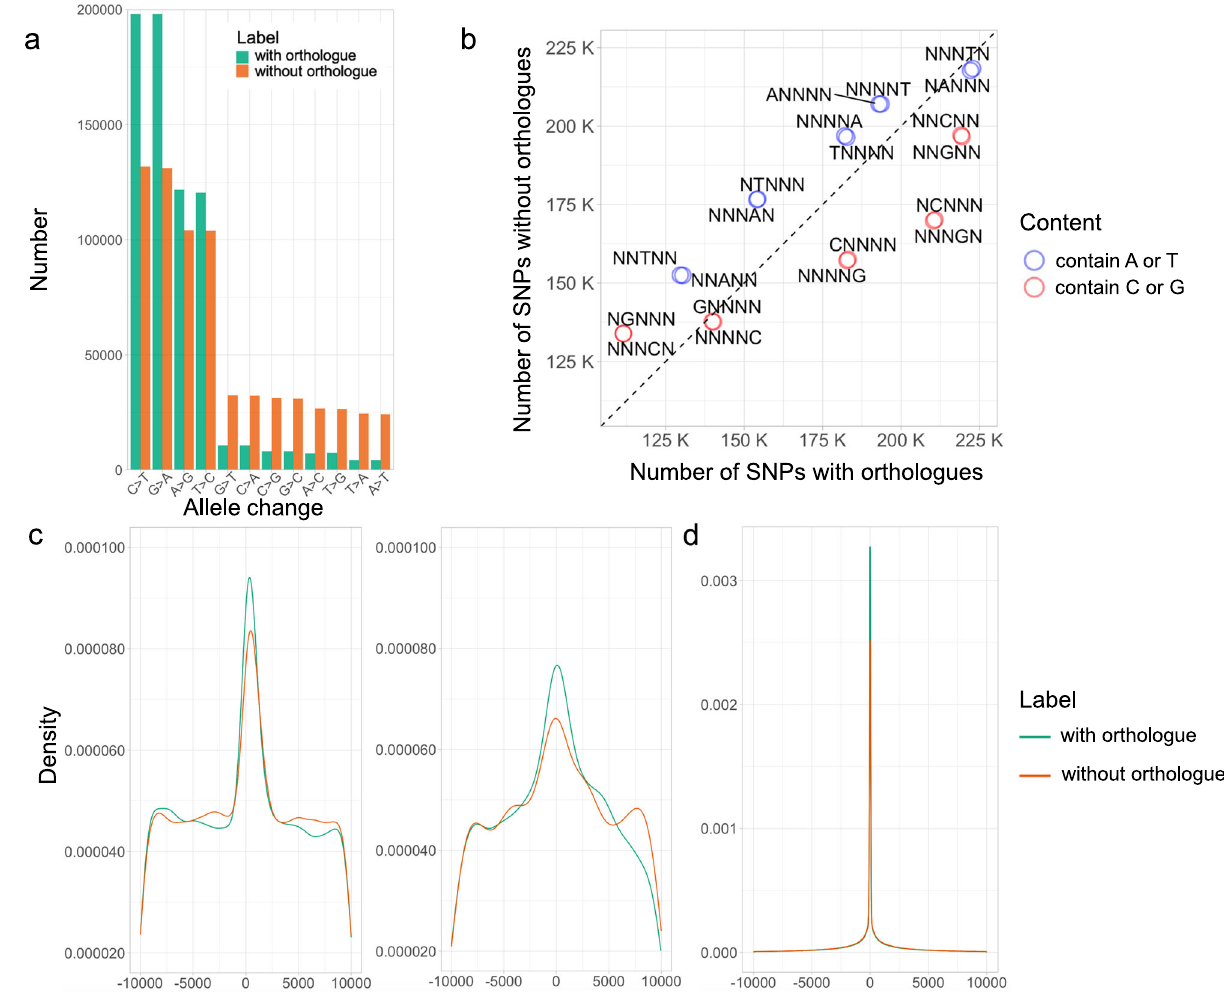
Fig. 2 The characteristics of human variants with cattle orthologues. The association of 1,395,750 human variants with different genomic features is shown (697,875 human variants with orthologues in cattle and an equally sized random sample of 697,875 human variants without known orthologues in cattle). a Number of variants with or without orthologues by their observed allele changes (reference > alternative). The data underlying this plot can be found in Supplementary Data 2. b Number of SNPs with different 5-mer fl anking sequences among variants with or without orthologues. Each circle represents a 5-mer fl anking sequence with a speci fi c base at a certain position, and the circle color indicates whether the speci fi c base is C/G or A/T. The black dashed line represents parity, i.e., where the number of SNPs with orthologues equals the number of SNPs without known orthologues. All the 5-mer sequences are signi fi cantly different between the groups at a P -value less than 2.2 × 10 -16 (Chi-Squared test). c Density plots of distances of variants with or without orthologues to processed pseudogenes and snoRNAs (plot restricted to within 10 kb). Distances of variants to processed pseudogenes and snoRNAs are different between groups at P -values less than 3.2 × 10 -5 (Two-sample Kolmogorov-Smirnov test). d Density plot of distance between variants with or without orthologues to chromatin regions marked by H3K9ac in the human H9 cell line (plot restricted to within 10 kb). Distance to these regions is different between groups at P -value less than 1.8 × 10 -3 (Two-sample Kolmogorov-Smirnov test). The data underlying this plot can